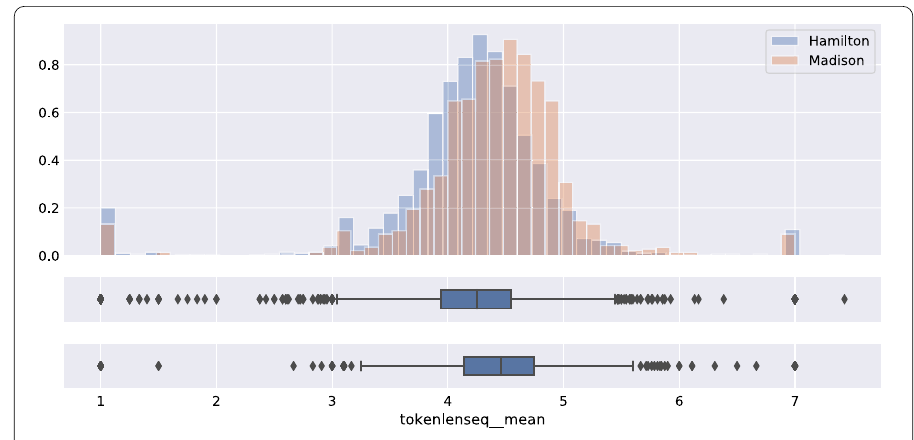
Figure 25 Normalized distribution plot of mean token lengths for sentences Hamilton and Madison